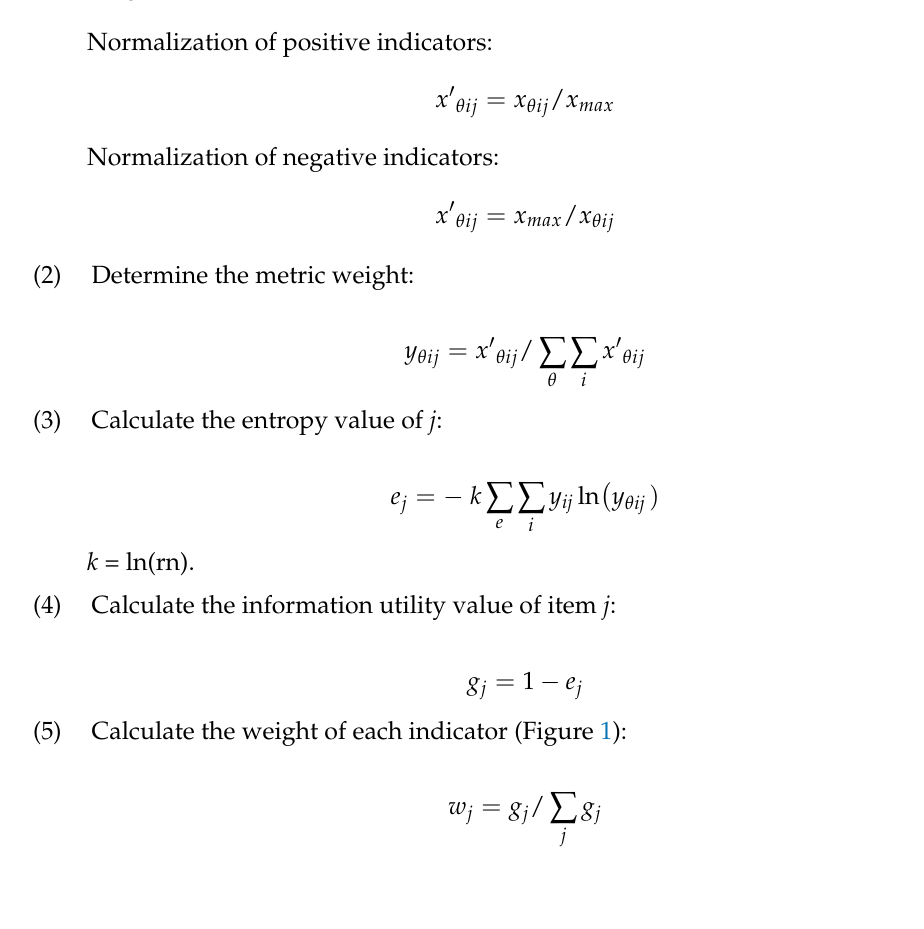
Figure 3. Evaluation factor index weight for CT and OWB systems. It mainly represents the weight of 18 evaluation factors such as number of 5A tourist attractions in cultural tourism and subjective well-being.